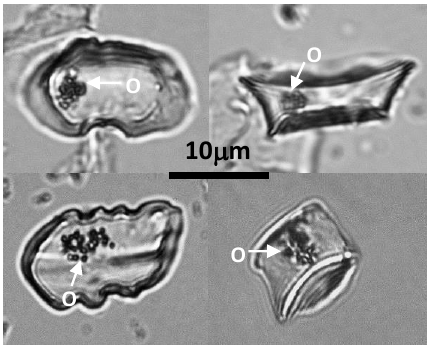
Figure 3. NL microscopy images of GSC phytolith types from the wheat TD-F-L sample showing opaque areas